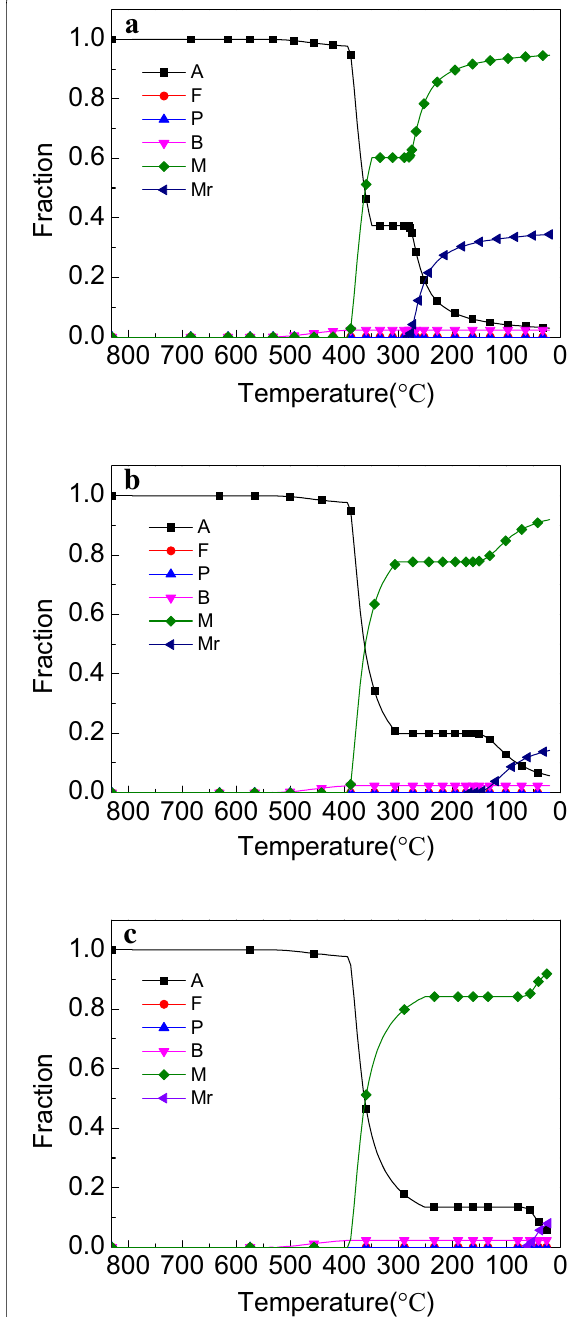
Figure 11 Microstructure evolution process of the side of U-cap part: a P T 350 °C; b P T 300 °C; c P T 250 = = =